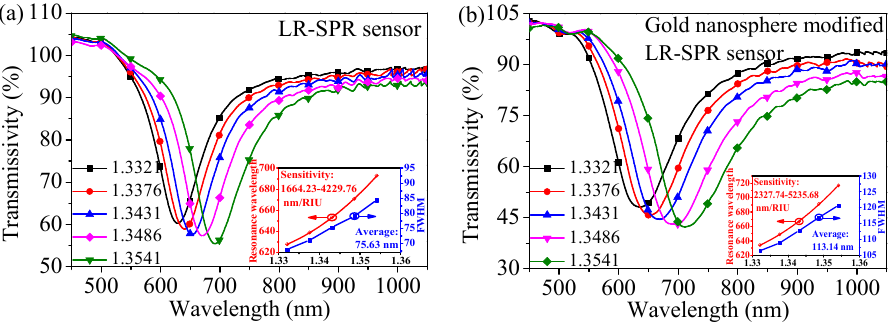
Figure 6. The resonance spectra of the ( a ) LR-SPR sensor and ( b ) gold nanosphere-modified LR-SPR sensor. Inset: red curve represents the binomial fitting of refractive index and resonance wavelength, and the tangent slope at each point represents sensitivity, and blue curve represents the FWHM variation with different refractive index.